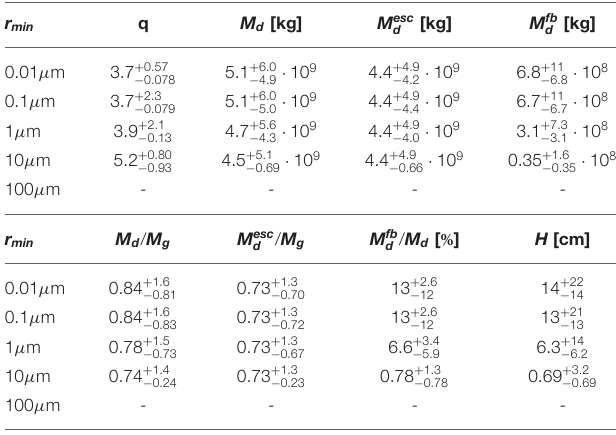
FIGURE 10 | The total escaping dust mass, M esc d , is shown as a function of the power-law index for five different minimum dust radii, r min . The horizontal dashed lines show the nominal ejected dust mass (green) and the maximum ejected dust mass (red). TABLE 5 | Power-law exponents, dust mass loss, dust-to-gas ratio, and fall back as a function of the smallest dust size (see Figure 10